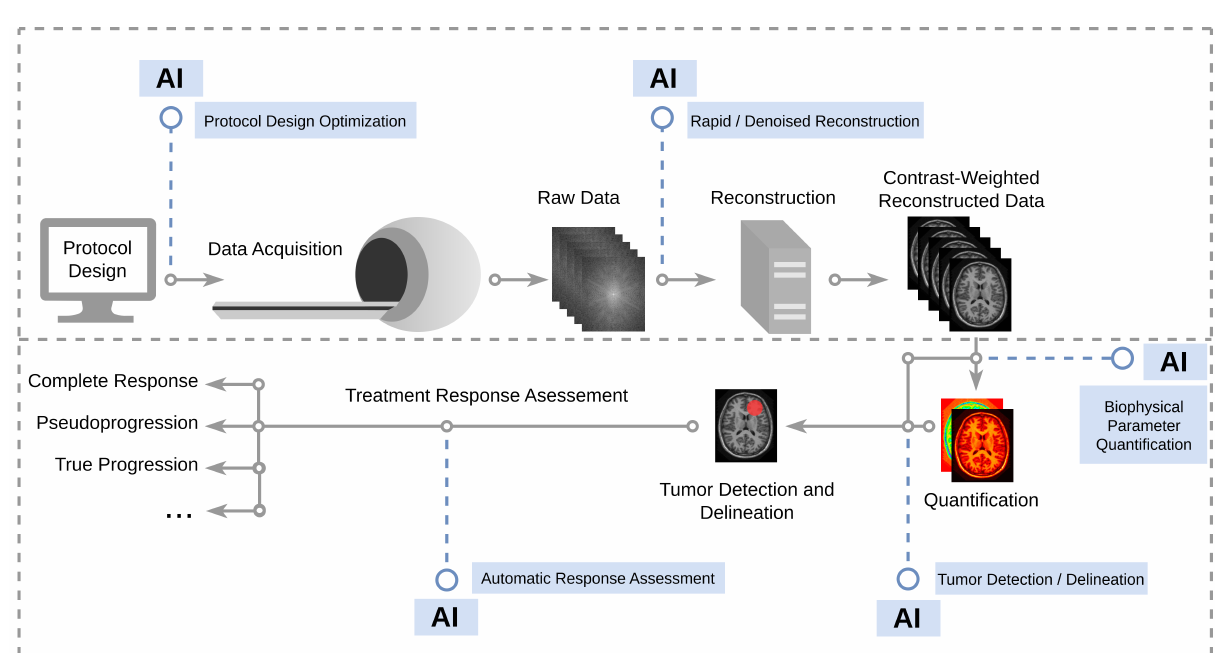
Figure 7. AI-based interventions along the imaging pipeline, allowing automatic and optimized proto- col design, faster and denoised image reconstruction, rapid quantification of biophysical parameters, automatic tumor delineation, and automatic classification of tumor